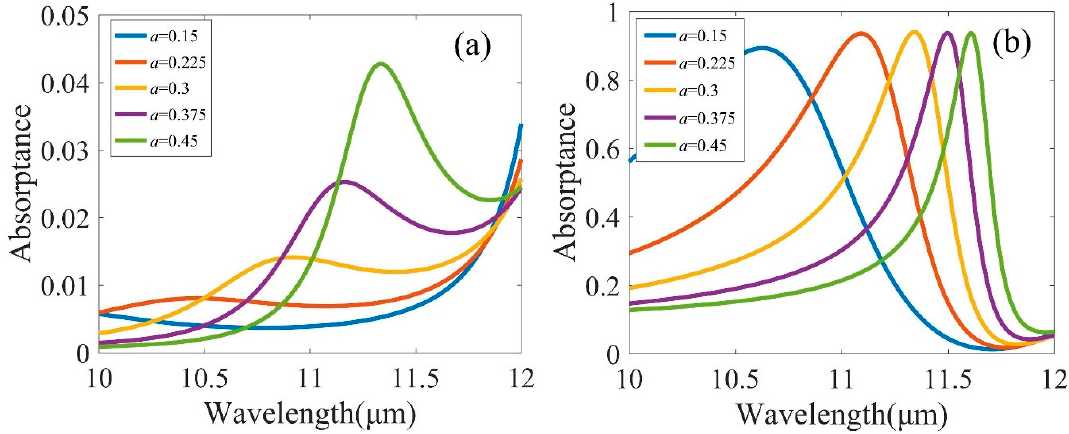
Figure 4. Absorption spectra for various height of ( a ) GST with amorphous (aGST) and ( b ) crystalline (cGST) stable structural phases, respectively. Other geometric parameters were the same as used in Figure 2.